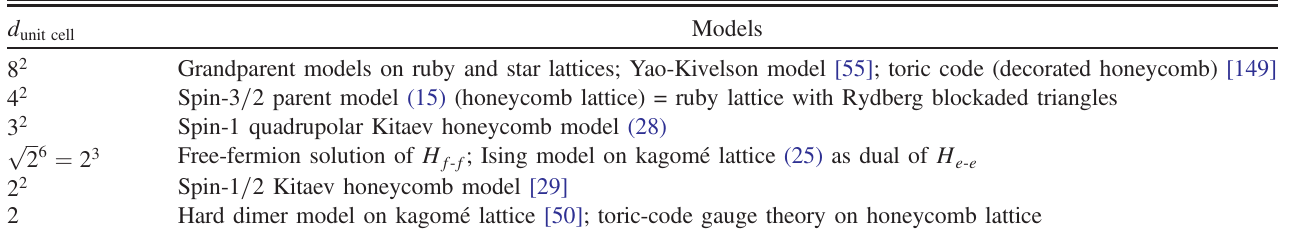
Models ; Ising model on kagom´e lattice (25) as dual of H f - f e - e